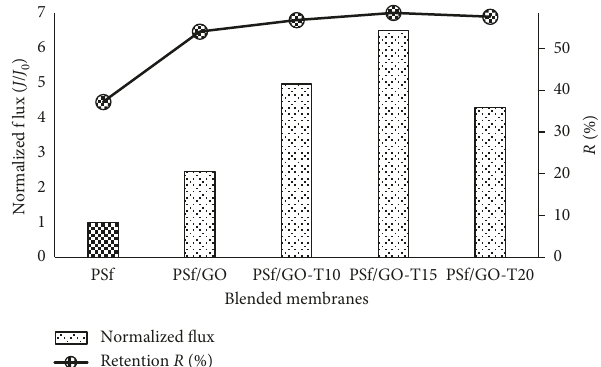
Figure 9: Normalized permeability of unblended and blended membranes.